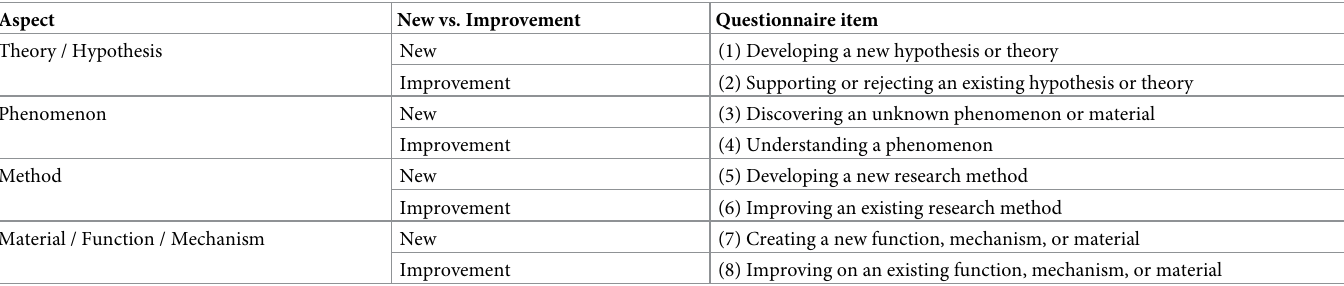
Table 2. Questionnaire of novelty. Aspect New vs.